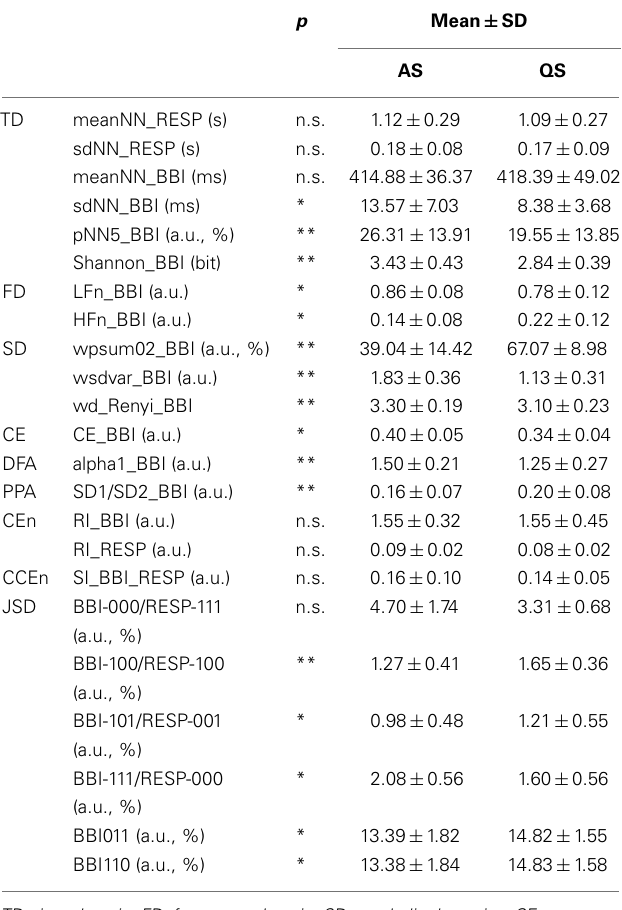
Table 2 | Univariate and bivariate indices comparing between active sleep (AS) and quiet sleep (QS)